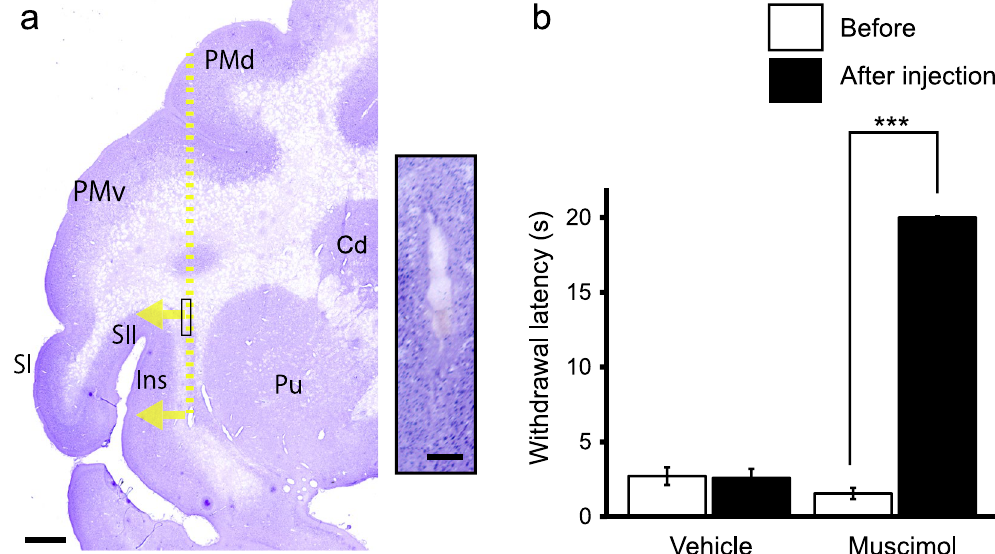
Figure 5. Effect of bilateral inactivation of the secondary somatosensory cortex (SII) and the insular cortex (Ins) on oxaliplatin-induced cold hypersensitivity. ( a ) Representative Nissl-stained section showing brain microinjection sites from oxaliplatin-treated macaques. The yellow dotted line indicates the needle track, and arrows indicate the direction of muscimol diffusion. Scale bar = 2 mm. The inset is a high-magnification photomicrograph of the needle track in the area shown by the box on the low-magnification photomicrograph. The injection sites were confirmed to be located within white matter beneath SII/Ins, within 2 mm from the boundary of the gray matter, in both muscimol-injected macaques and the vehicle-injected macaque. Scale bar in the inset = 200 μ m. Cd. Caudate nucleus; PMd, dorsal premortor cortex; PMv, ventral premortor cortex; Pu, putamen; SI, primary somatosensory cortex. ( b ) Bilateral microinjection of muscimol to SII/Ins in oxaliplatin- treated macaques significantly increased mean withdrawal latency to 10 °C cold ( *** P < 0.001, compared to pre-muscimol injection (“Before”) Paired t-test), indicating an involvement of SII/Ins in cold hypersensitivity. No change in the withdrawal latency was observed in a vehicle-injected oxaliplatin-treated macaque. Values are expressed as mean ±